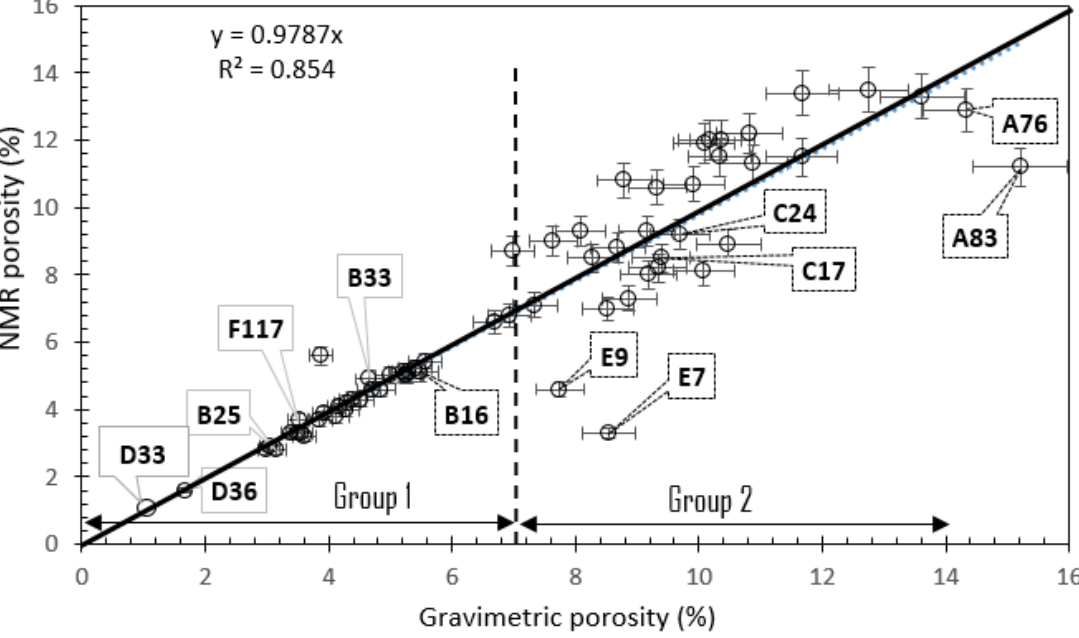
Energies 2019 , 12 , x FOR PEER REVIEW Figure 14. Cross-plot of NMR porosity and gravimetric porosity for 56 subsamples.